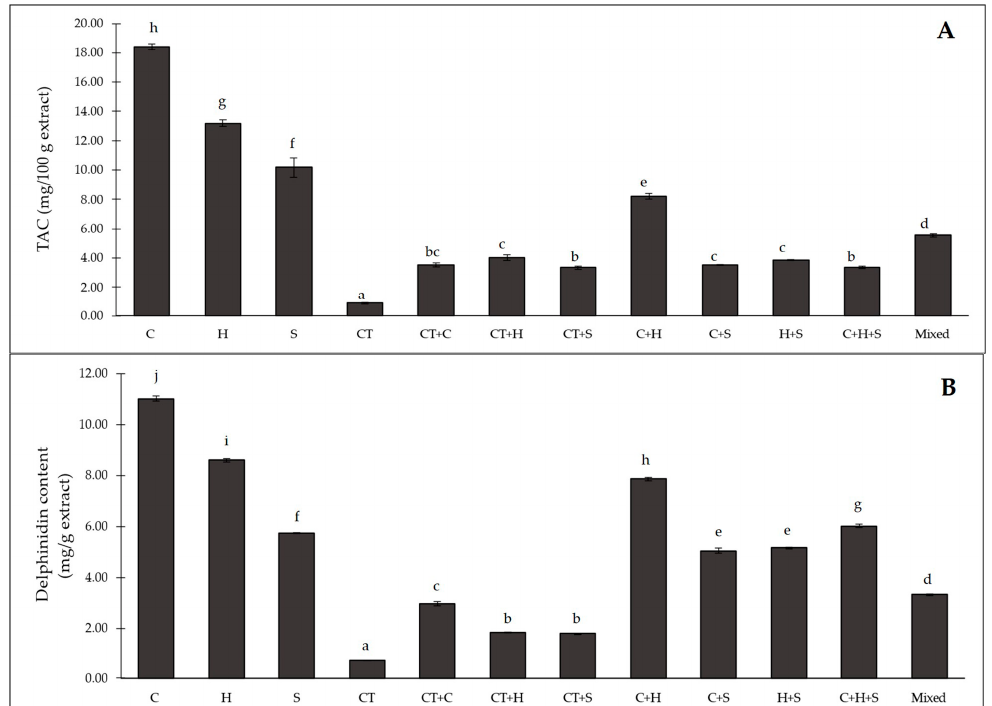
Figure 2. ( A ) Total anthocyanin content (TAC) and ( B ) delphinidin content in different extracts from purple corn and butterfly pea. C: cob extract; H: husk extract; S: silk extract; CT: butterfly pea extract; CT + C: butterfly pea and cob extract; CT + H: butterfly pea and husk extract; CT + S: butterfly pea and silk extract; C + H: cob and husk extract; C + S: cob and silk extract; H + S: husk and silk extract; C + H + S: cob, husk, and silk extract; mixed: combination of butterfly pea, cob, husk, and silk extracts. The different superscript letters (a–j) indicate a significant difference between each content of the extracts using Tukey’s test ( n = 3, p < 0.05).